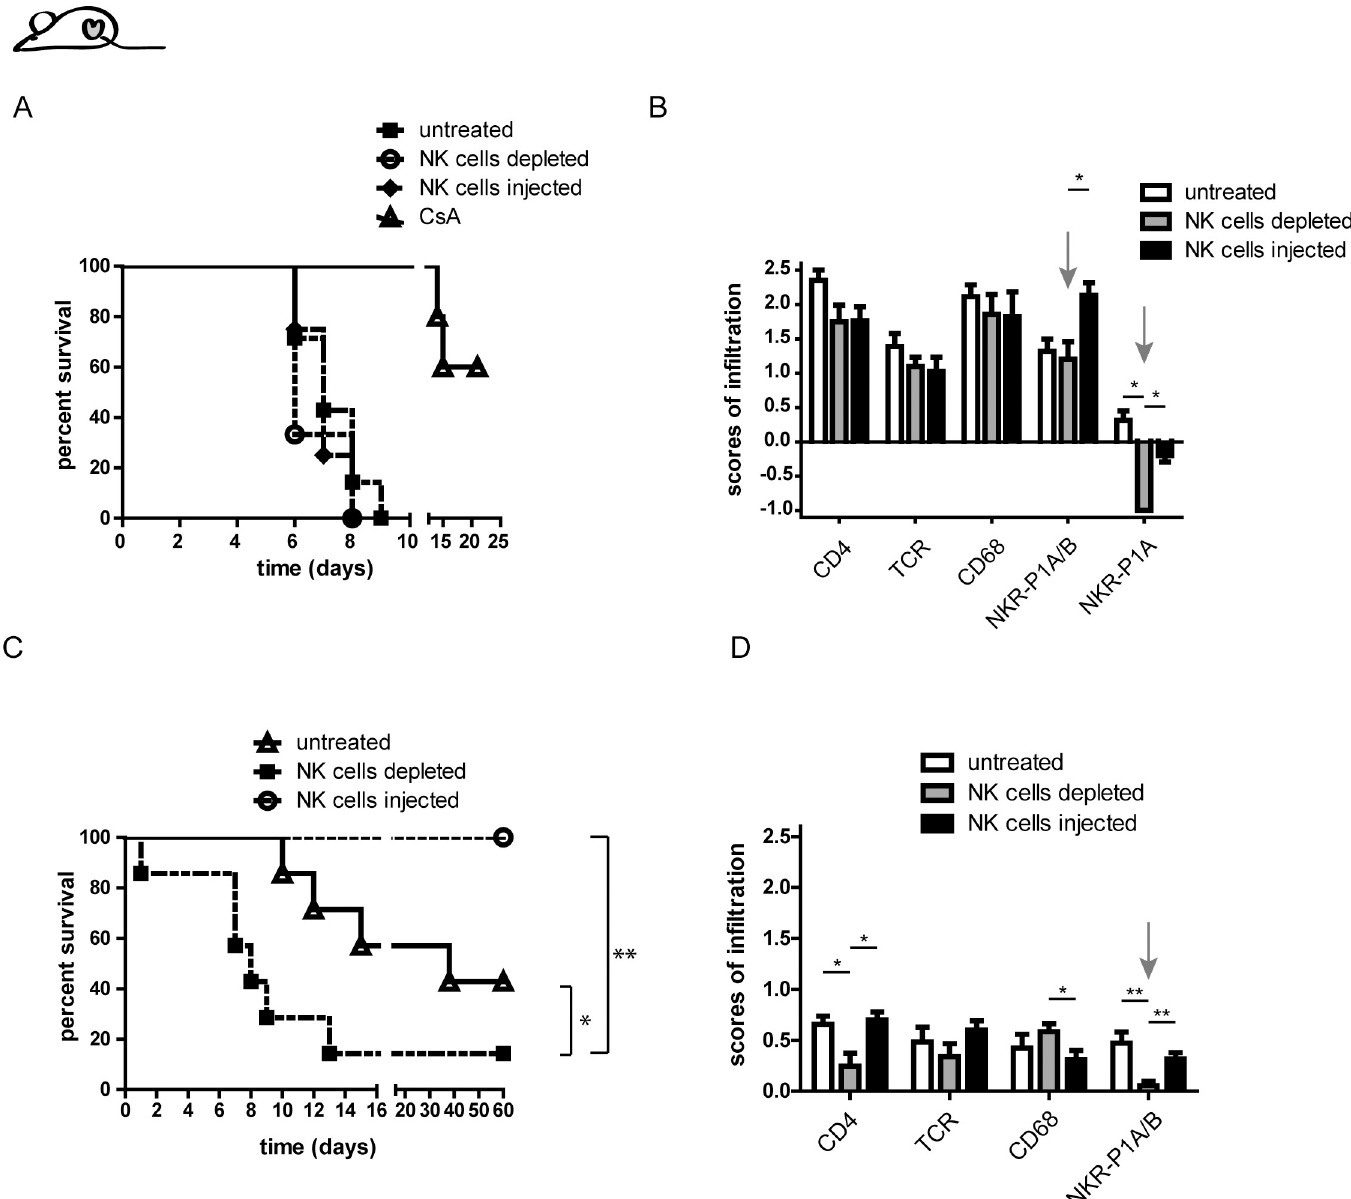
Fig 4. Heart graft rejection in Lew.1a recipients is significantly influenced by the presence of NK cells. (A) Kaplan-Meier presentation of allogeneic graft survival in Lew wt recipients without further treatment (untreated), with a single subcutaneous application of 500 μ g HT30 one day prior HTx (NK cell depleted) and with an intravenous injection of 1-2x10 6 IL-2 activated syngeneic NK cells subsequently after successful surgery (NK cell injected). An additional group of recipients was treated with a daily injection of CsA (1.25 mg/kg body weight). (B) Infiltration of allogeneic grafts of Lew wt recipients without further treatment and after NK cell depletion or NK cell injection after graft rejection. The grafts were predominantly invaded by monocytes/macrophages, which were only marginally affected by NK cell manipulation. Of note, NK cell depletion caused a decrease of NKR-P1A + (NK cells and NKT cells) cells below the baseline of syngeneic controls whereas the NKR-P1A/B + (NK cells, NKT cells and Monocytes) cells were unaffected by the depletion (grey arrows), indicating abundant infiltration of NKR-P1B + monocytes. (C) Kaplan-Meier presentation of allogeneic graft survival in Lew.1a rats treated accordingly to Lew wt recipients in (A). Contrary to the fast rejection model, Lew.1a recipients revealed accelerated rejection in the absence of NK cells and a reverse effect after injection of syngeneic NK cells, which induced graft survival over the complete observation period indicating establishment of graft acceptance. (D) Allogeneic graft infiltration of CD4 + , CD68 + , TCR + and NKR-P1A/B + expressing cells in Lew.1a recipients was only slightly elevated when compared to syngeneic grafts. However, interestingly and in contrast to Lew wt recipients the NK cell-depleted Lew.1a rats revealed a diminished fraction of NKR-P1A/B + cells, indicating that in these recipients NK and NKT cells were the dominant population among these positive cells (grey arrow). Results are presented as mean ± SEM of at least 5 individuals per group. Significance is indicated with � for p-values � 0.05, �� for p-values � 0.005 and ��� for p-values � 0.0005. If no asterisk is shown in the respective graph the results were not significantly different.